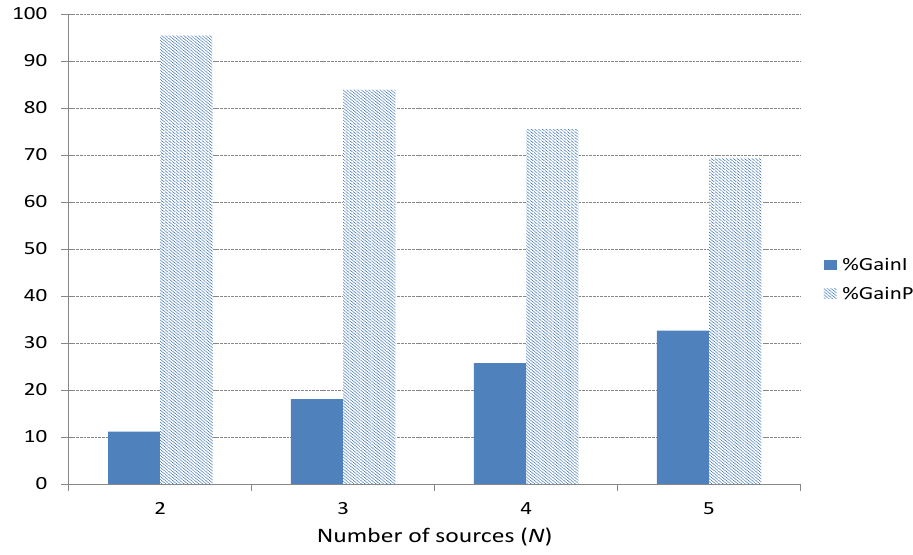
Figure 14. Gain in terms of packet losses for I and P video frames using the game-theoretical scheme with respect to not using